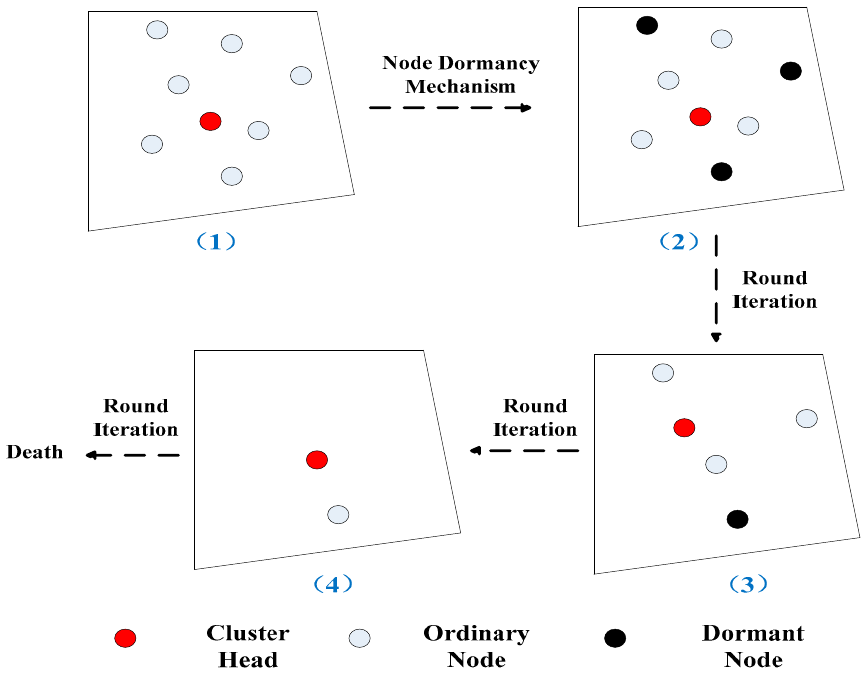
Figure 8. Node dormancy diagram of a cluster.